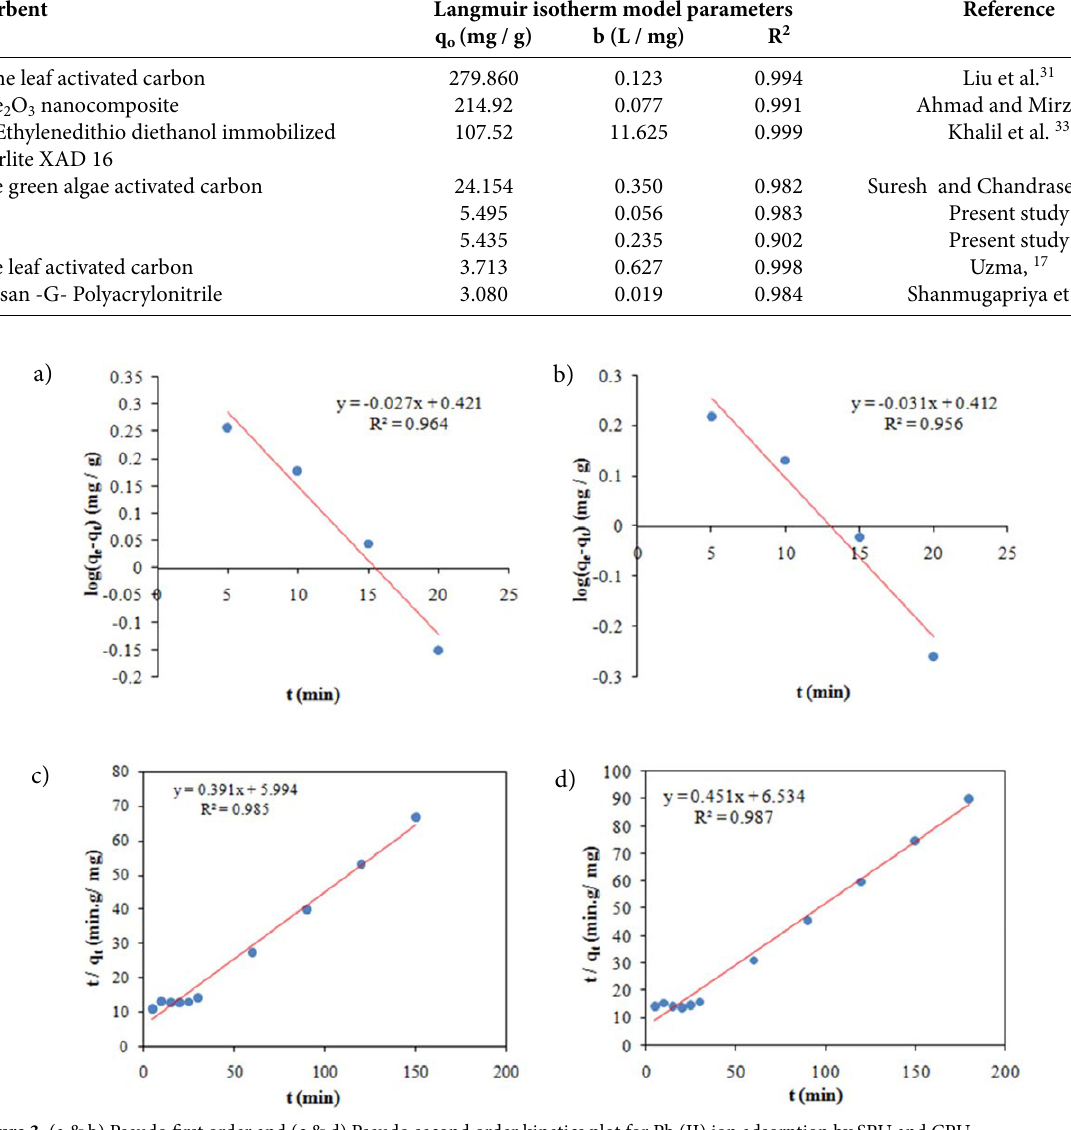
Figure 3. (a & b) Pseudo first order and (c & d) Pseudo second order kinetics plot for Pb (II) ion adsorption by SPU and